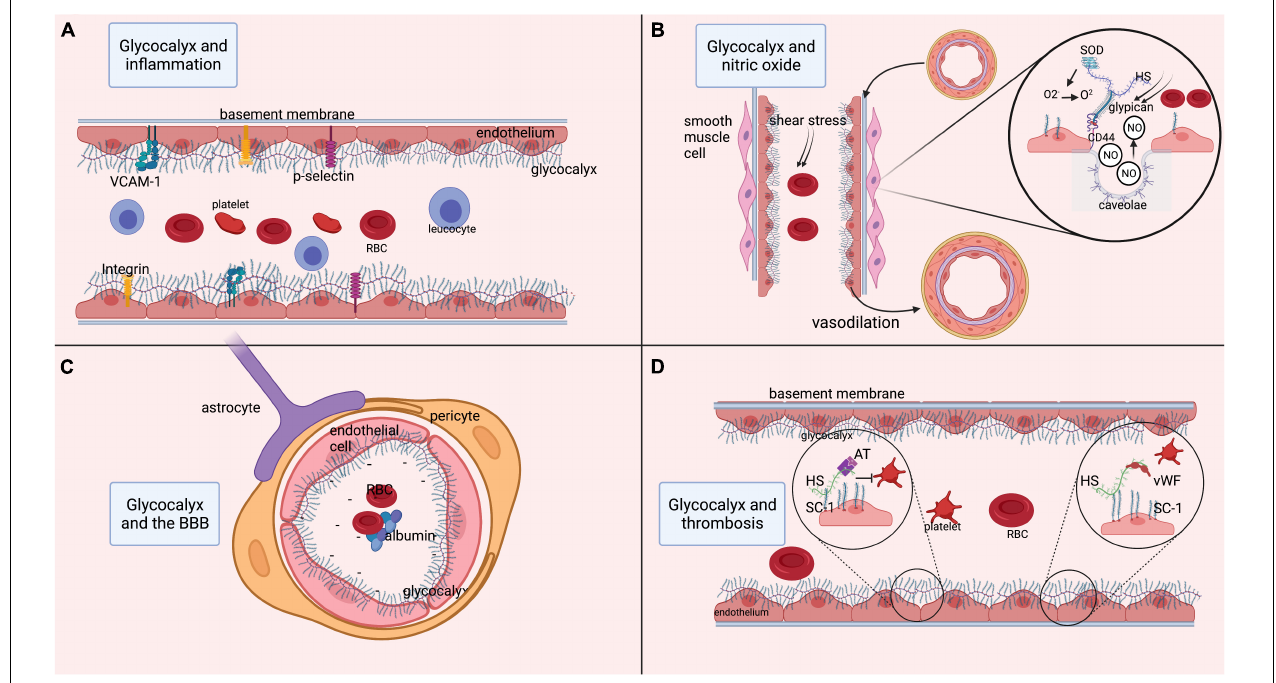
FIGURE 1 | Functions of the glycocalyx. (A) Role of the glycocalyx in adhesion of platelets and inflammatory cells such as leukocytes. Multiple endothelial glycoproteins such as selectins, integrins, and cell-adhesion molecules (VCAM-1) are docked within the glycocalyx. As such, the glycocalyx prevents their activation and thereby prevents inflammatory processes. (B) Process of releasing nitric oxide (NO) from the endothelium in response to shear stress. Shear stress is sensed by heparan sulfate, which is bound to glypican. Glypican then attaches to the transmembrane CD44. This mechanical signal in response to shear stress is translated into an intracellular signaling process resulting in the release of NO from endothelial caveolae. The released NO induces relaxation of vascular smooth muscle cells, resulting in vasodilatation. Moreover, superoxide dismutase is bound to heparan sulfate and can convert oxidative O 2 − into O 2 , thereby regulating the level of free radicals. (C) Role of the glycocalyx in maintenance of the BBB. Within cerebral microcirculation, the glycocalyx is also part of the blood-brain barrier (BBB). The BBB is further composed of tightly connected endothelial cells encapsulated by pericytes that are surrounded by astrocytic feet. At the luminal side of the endothelium, the glycocalyx layer prevents large molecules from passing the BBB. Since the glycocalyx is negatively charged, the BBB is not permeable to negatively charged cells such as platelets and red blood cells, or proteins like albumin. (D) Anti-coagulant function of the glycocalyx, as it docks anti-coagulant molecules like anti-thrombin, tissue factor pathway inhibitor and the von Willebrand factor (vWf). In states of increased shear stress, the vWf is elongated and able to bind platelets that in turn attach to the endothelium and initiate coagulation. AT, anti-thrombin; BBB, blood-brain barrier; ET, endothelin; GAG, glycosaminoglycan; HS,